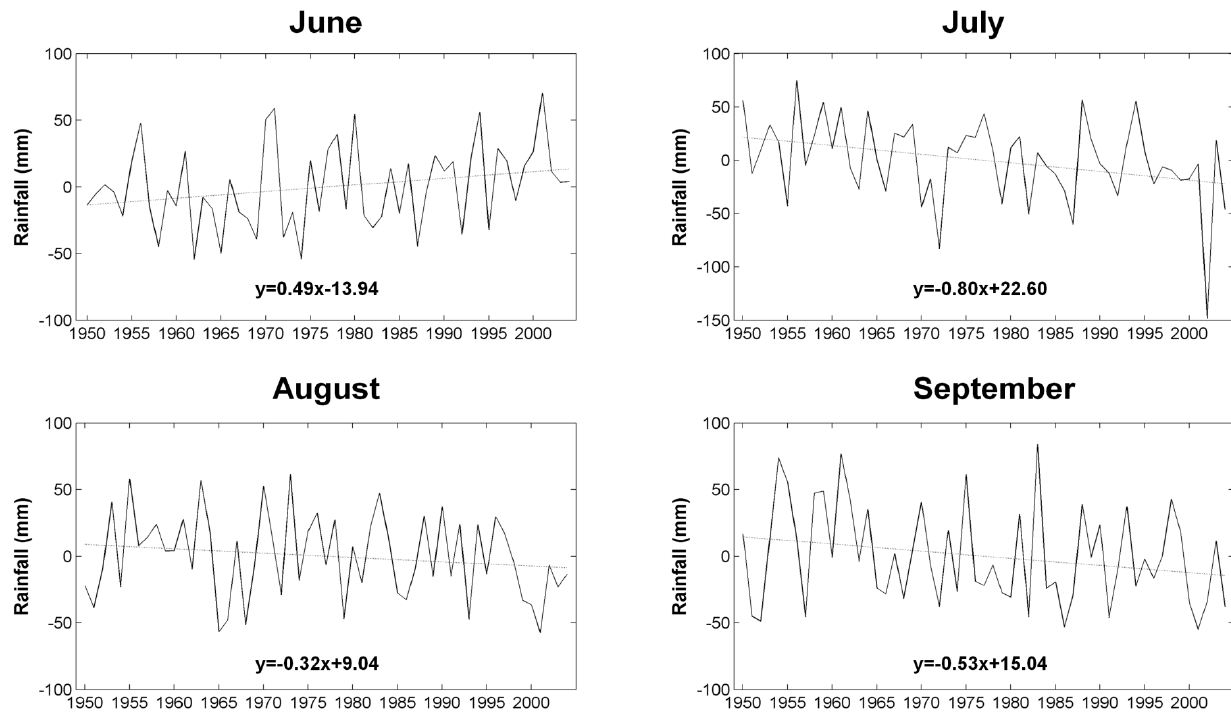
Fig. 7. Time series and linear trends of monthly separated All India Monsoon Rainfall for June, July, August and September from 1979 to 2004. June rainfall exhibits a characteristic increasing trend, while all remaining monsoon months show a significant weakening trend in recent past decades.